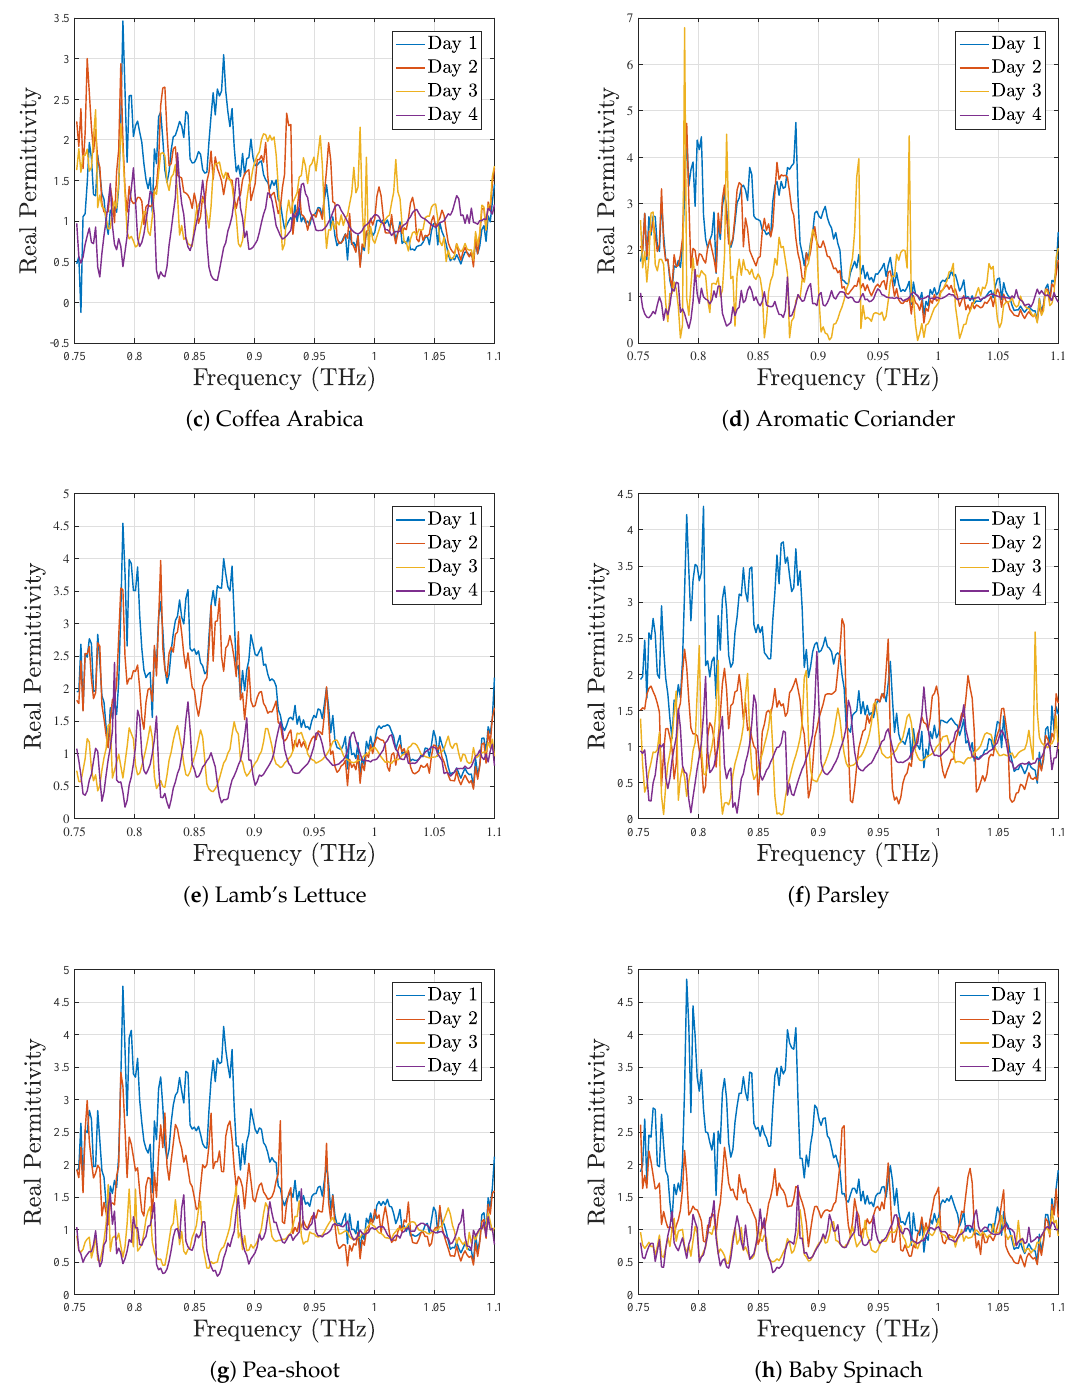
Figure 4. Real part of permittivity of all eight leaves measured on four consecutive days. Leaves become transparent to electromagnetic waves with the passage of days as seen by the decrease in the